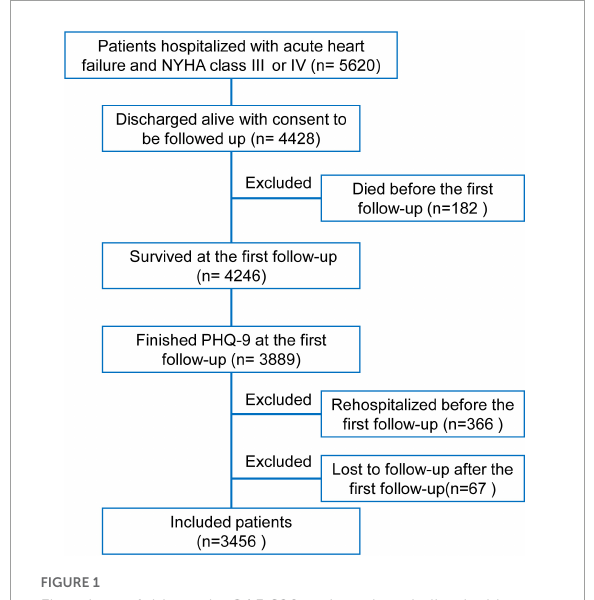
FIGURE1 Flowchart of this study. Of 5,620 patients hospitalized with acute heart failure and New York Heart Association class III or IV in the Heart Failure Registry of Patient Outcomes study, 4,428 patients were discharged alive with consent to be followed up. After excluding 182 patients who died before the first follow-up, 3,889 of 4,246 survived patients had valid patient health questionnaire-9 scores. To avoid the effects of repeated hospitalizations in a short period on assessing depressive symptoms, 366 patients who had already been rehospitalized before the first follow-up were excluded. Meanwhile, 67 patients lost to further follow-up calls after the first follow-up were excluded. Finally, a total of 3,456 patients were included in